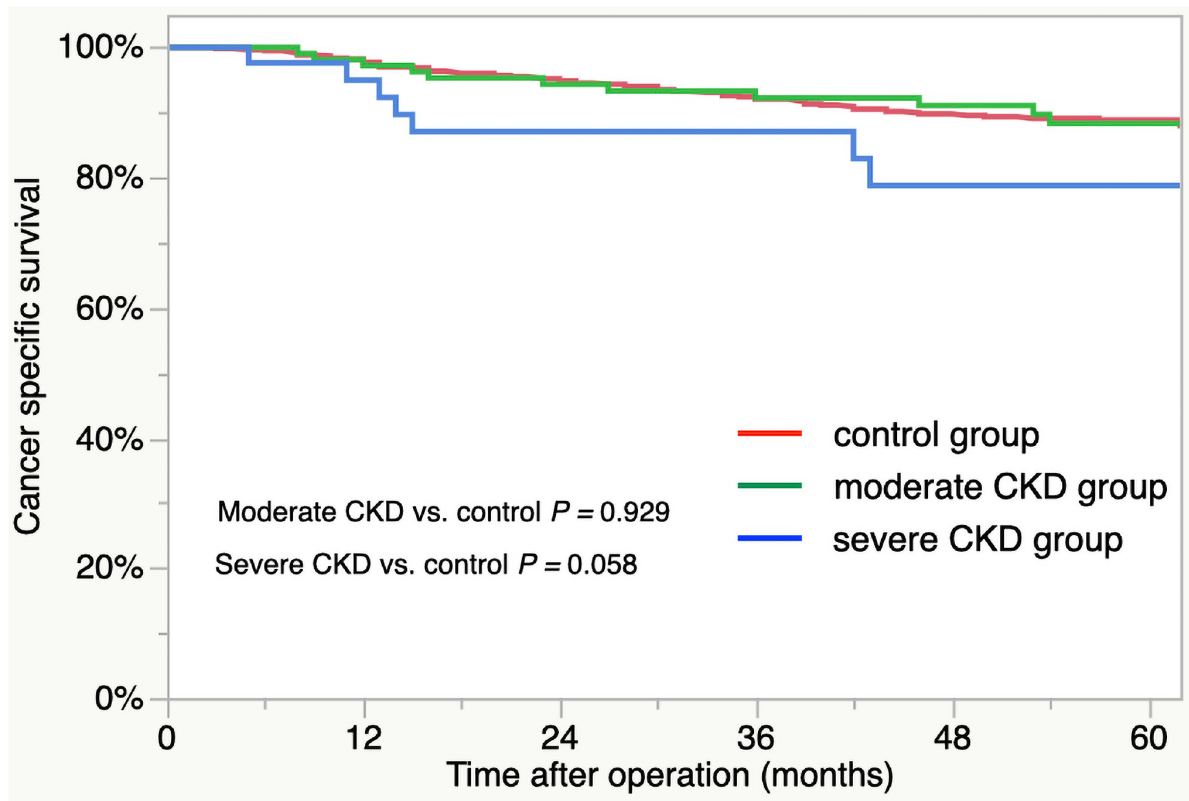
Fig 2. Cancer-specific survival of CKD groups: Control group (red line), moderate CKD group (green line), and severe CKD group (blue line).